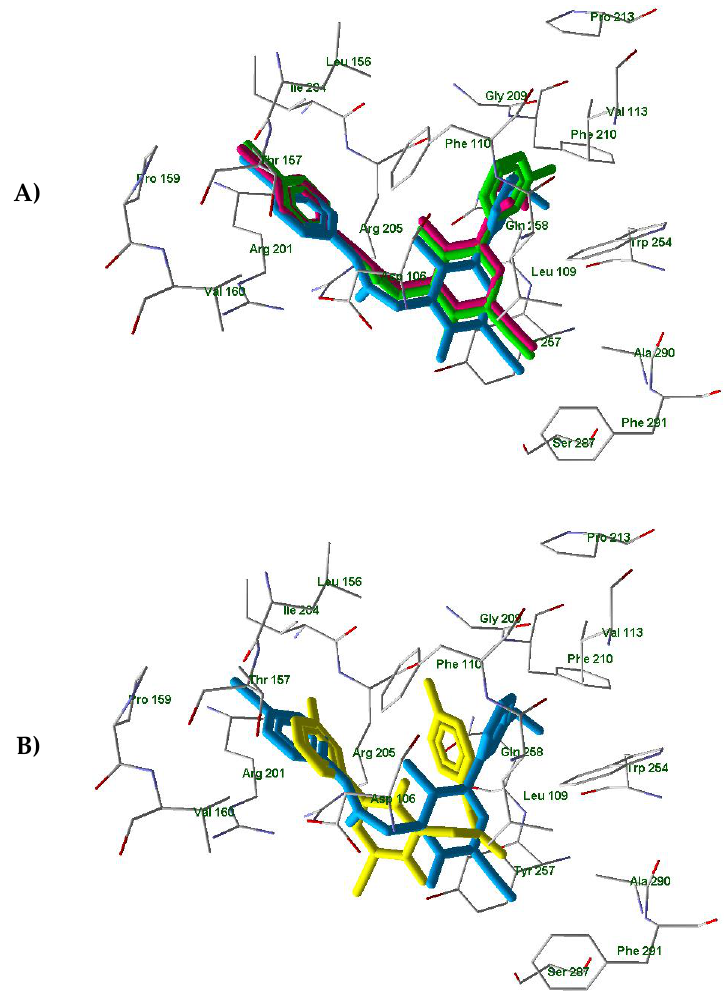
Figure 4. The superimposed docking poses of compounds AMC3 (light-blue) [25], AMC4 (magenta), and 14a (light-green) in the FPR1 binding site. The heterocyclic fragments of molecules AMC3 , AMC4 , and 14a are oriented in a similar fashion with meta -substituted benzene rings of compounds AMC3 and 14a and the ethoxy carbonyl group of AMC4 occupying the same area of space within the receptor cavity (Panel A); AMC3 (light-blue) [25] and 14c (yellow) docked in FPR1 with different orientations of N-phenylacetamido and phenylpyridinone moieties. (Panel B). Residues within 4 Å from AMC3 pose are